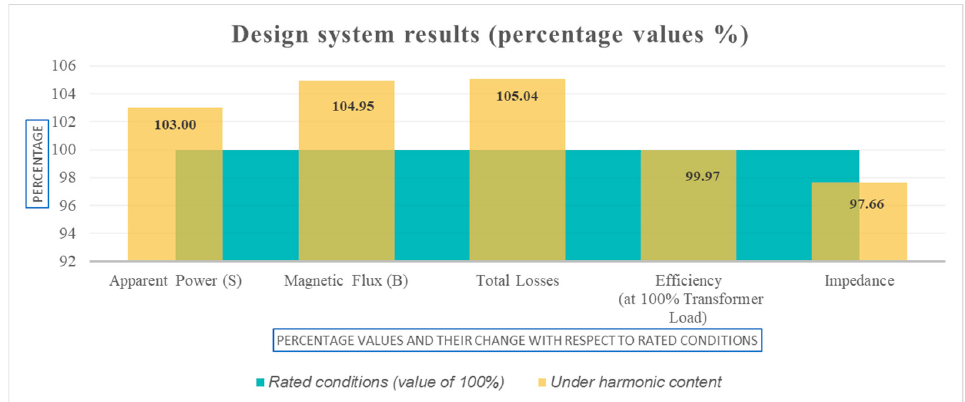
Figure 3. Percentage changes between transformer standard design and harmonic profile design.